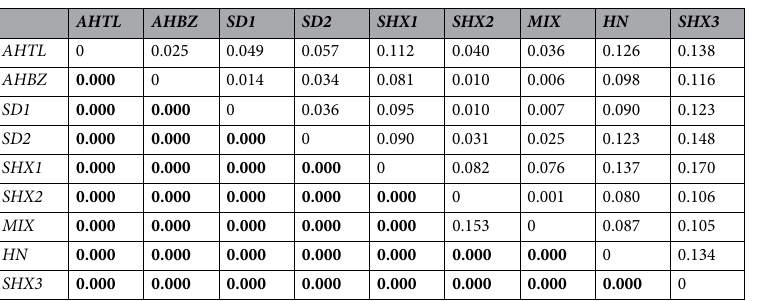
Table 3. Pairwise multi-locus F ST values for clustered samples. Note: F ST values are above the diagonal and associated P- values below. All P -values in bold were judged significant after sequential Bonferroni